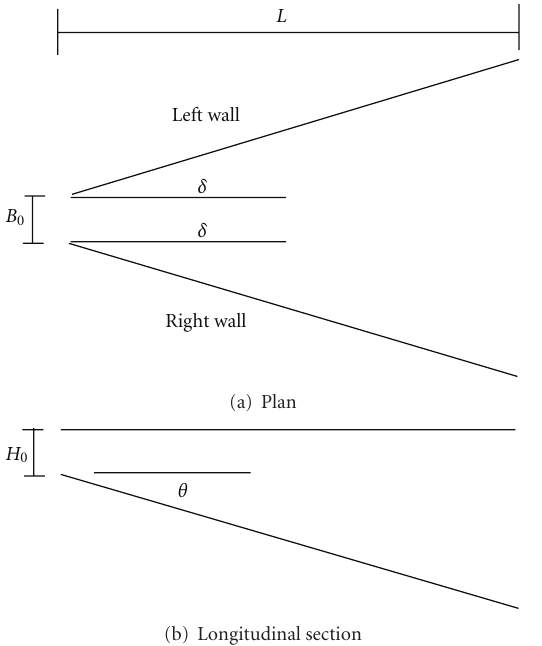
Figure 4: Plan and longitudinal section view of diverging channel with sloping bottom at the simulation of Bournet et al. [29].